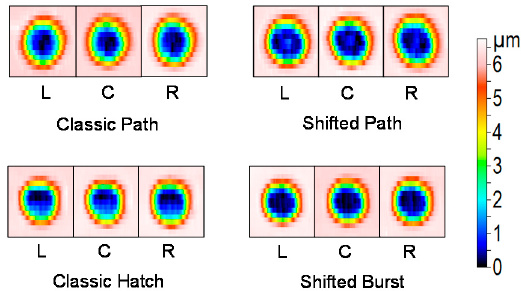
Figure 8. Comparison of the depth profiles of the dimple produced by different laser texturing methods (scanning strategies) at their highest allowed scanning speeds.